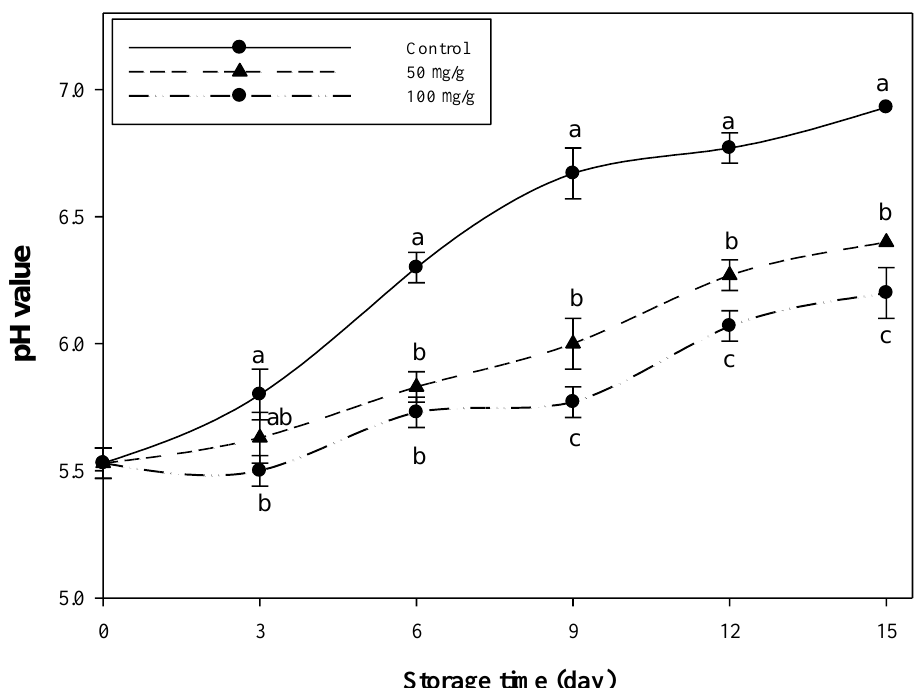
Figure 2. Variations in the pH of minced beef combined with catfish glycoprotein (CFG) at different levels (0, 50 and 100 µg g −1 ) during 15 days storage at 4 °C. Every value is the average of three replicates ± SD. Different letters for the same time storage refer to significant differences ( p < 0.05).